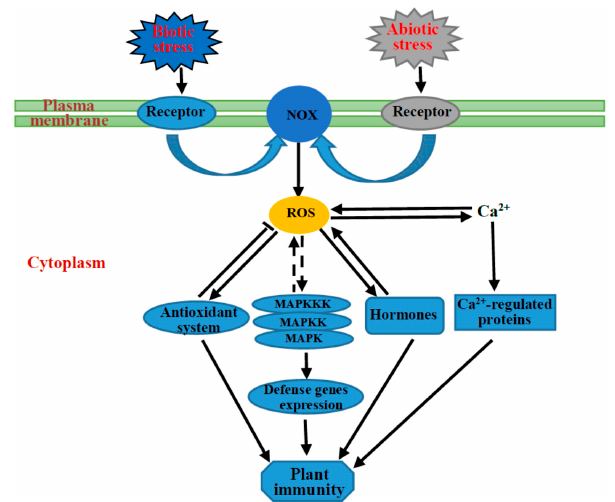
Figure 4. The similar regulation mechanism under biotic stress and abiotic stress responses of plants. Upon stress factor perception, the ROS produced from NOX regulate response to stress mainly through four pathways, the antioxidant system, MAPK cascades, hormones and Ca 2+ -regulated proteins. The solid lines and dashed lines represent determinate and potential interactions, respectively. Beyond this, plants share a set of antioxidant systems when suffering from stresses whether biotic or abiotic stresses [9,121]. Any kind of biotic or abiotic stress leads to an increased level of ROS production. When the concentration of ROS is excessive, it will act as damaging [7,11–13]. Thus, plant stress tolerance can be improved by increasing in vivo levels of antioxidant systems. The plant antioxidant defense system can be divided into two parts, the non-enzymatic system and the